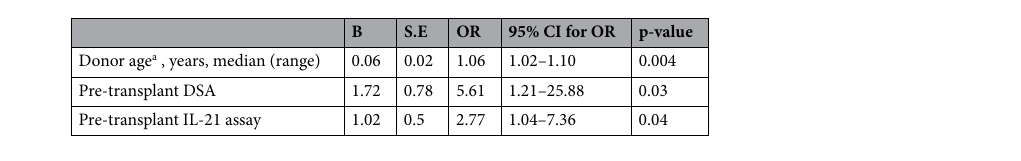
Table 2. Binary logistic